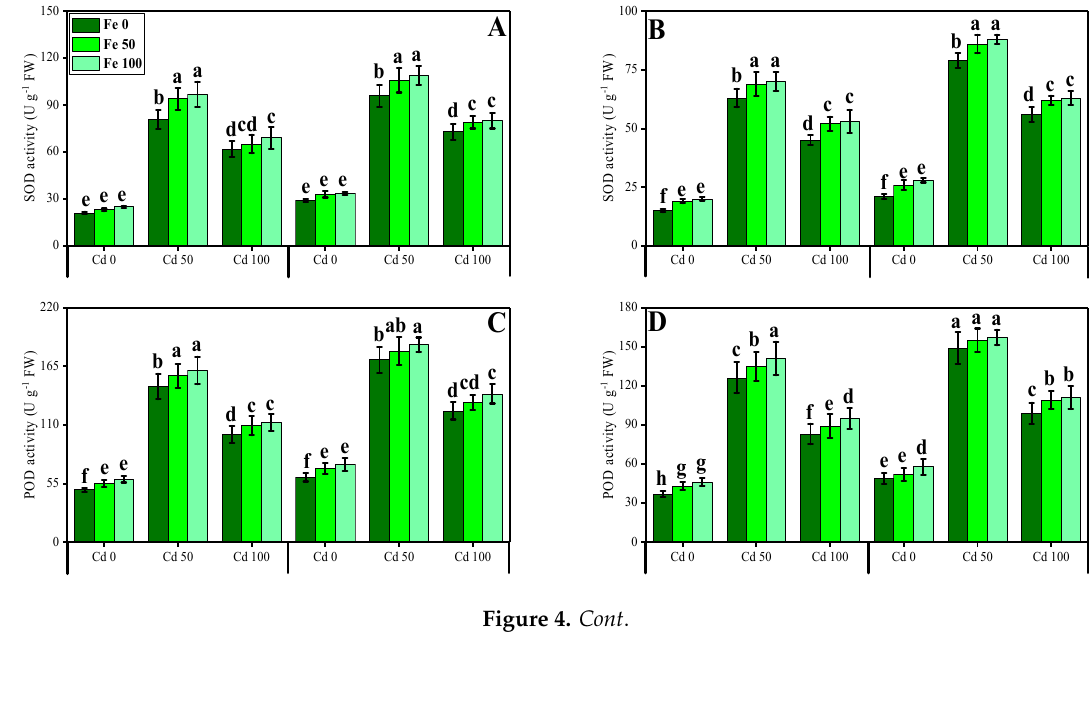
Figure 4. Effect of different concentrations of exogenous application of FeSO 4 (0, 50, and 100 µM) on antioxidant activities, i.e., SOD activity in the roots ( A ), SOD activity in the leaves ( B ), POD activity in the roots ( C ), POD activity in the leaves ( D ) CAT activity in the roots ( E ), CAT activity in the leaves ( F ), APX activity in the roots ( G ) and APX activity in the leaves ( H ) of Oryza sativa (cultivars) grown under different levels of Cd stress (0, 50, and 100 µM). Bars sharing different letter(s) for each parameter are significantly different from each other according to Duncan’s multiple range test ( p < 0.05). All the data represented are the average of four replications ( n = 4). Error bars represent the standard deviation (SD) of four replicates. 3.4. Effect of Exogenous Application of FeSO 4 on Non-Enzymatic Antioxidants, Sugars and Proline in O. sativa Genotypes under Toxic Concentrations of Cd In the present study, we also determined the contents of non-enzymatic antioxidant compounds (phenolics, flavonoids, ascorbic acid, and anthocyanin) from the leaves of O. sativa genotypes under the application of FeSO 4 , grown in Cd-polluted nutrient solution. The data regarding the non- enzymatic antioxidant compounds (phenolics, flavonoids, ascorbic acid, and anthocyanin) from the leaves of O. sativa genotypes grown under the application of FeSO 4 in Cd-polluted nutrient solution are presented in Figure 5. These results showed that the increasing concentration of Cd in the nutrient